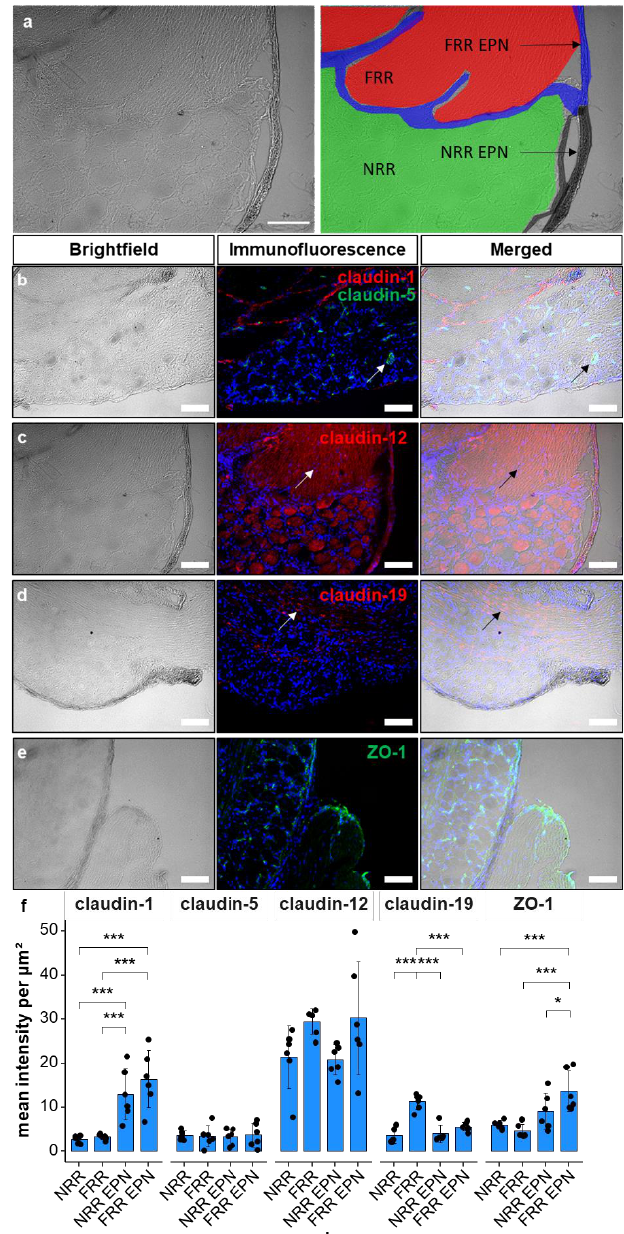
Figure 1. Claudin-1 immunoreactivity (IR) and ZO-1 IR are preferentially found in epi- / perineurium in rats’ dorsal root ganglia (DRGs), while claudin-19 IR is most abundant in the fiber-rich region. Classification into neuron rich region (NRR, green), NRR epi- / perineurium (EPN, black), fiber rich region (FRR, red), and FRR-EPN (blue) is shown in ( a ). Control DRG sections (CL) from Wistar rats were immunostained. IRs of claudin-1, claudin-5, and ZO-1 were quantified and compared between NRR and FRR, together with their putative EPN. Representative stainings for claudin-1 (red), claudin-5 (green) ( b ), claudin-12 ( c ), claudin-19 ( d ), and ZO-1 ( e ) are shown. Arrows point to structures identified as vessels ( b ), Schwann cells ( c ), and paranodes of Schwann cells ( d ). Quantification of the signal intensity in the specified areas ( f ). (Scale bars = 100 µ m; n = 5 or 6; claudin-1: NRR versus NRR-EPN, NRR versus FRR-EPN, FRR versus NRR-EPN, and FRR versus FRR-EPN: p < 0.0001; ZO-1: FRR-EPN versus NRR: p = 0.0003; FRR-EPN versus NRR-EPN: p = 0.0138; FRR-EPN versus NRR: p = 0.00018. No normal distribution: ZO-1 FRR. No variance homogeneity: claudin-1. Two-way ANOVA, Tukey HSD. * p < 0.05, *** p <